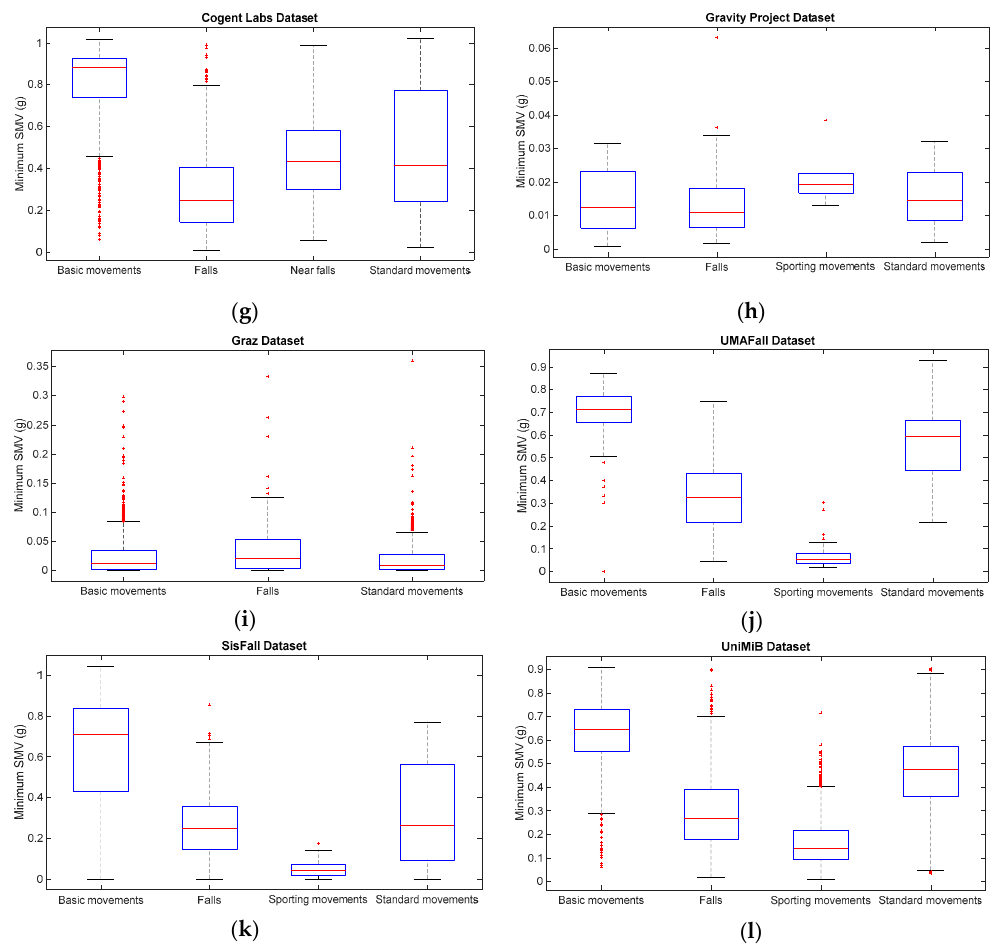
Figure 6. Boxplots of the of the minimum acceleration module for the falls and the three considered categories of ADL (for all the datasets only the acceleration signal at the waist or—if not available—at the thigh is considered). ( a ) DLR Dataset; ( b ) MobiFall Dataset; ( c ) Mobiact Dataset; ( d ) TST Fall Detection Dataset; ( e ) t-Fall Dataset; ( f ) UR Fall Detection Dataset; ( g ) Cogent Labs Dataset; ( h ) Gravity Project Dataset; ( i ) Graz Dataset; ( j ) UMAFall Dataset; ( k ) SisFall Dataset; ( l ) UniMiB SHAR Dataset.